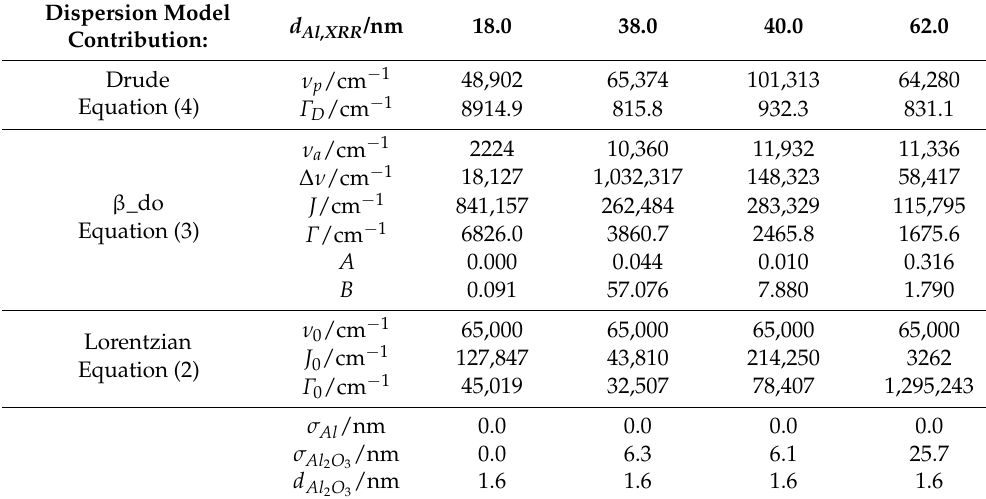
Table 7. Dispersion parameters of series 3 films (assisted evaporation).